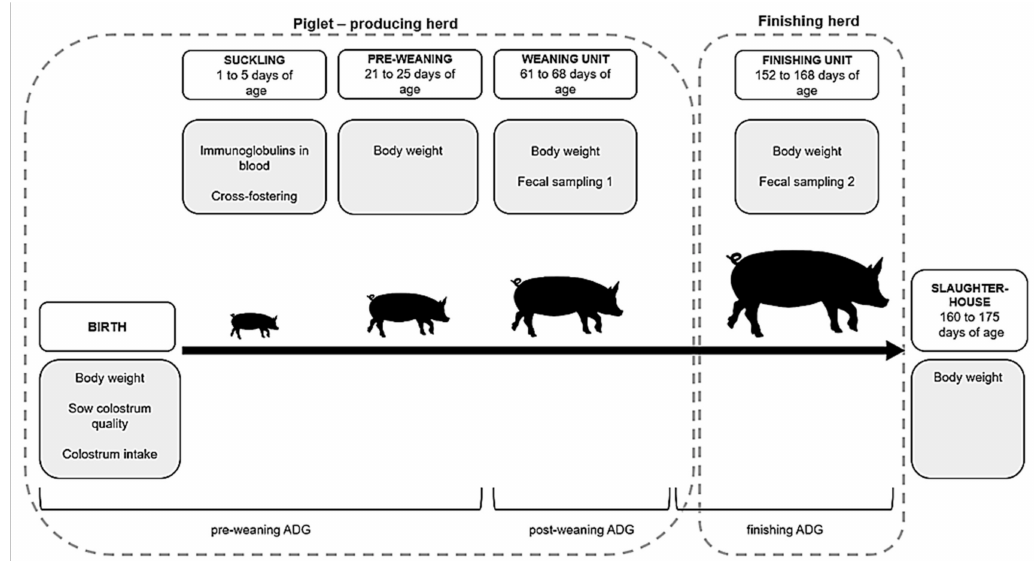
Figure 1. Follow-up of the study pigs from birth to slaughter in two herds (H1 and H2). White boxes represent production phases and age variation of study pigs at corresponding points. Gray boxes illustrate the procedures performed at each phase. Study pigs were transported from the piglet-producing herds to the finishing herds between fecal sampling points 1 and 2. ADG = average daily weight gain